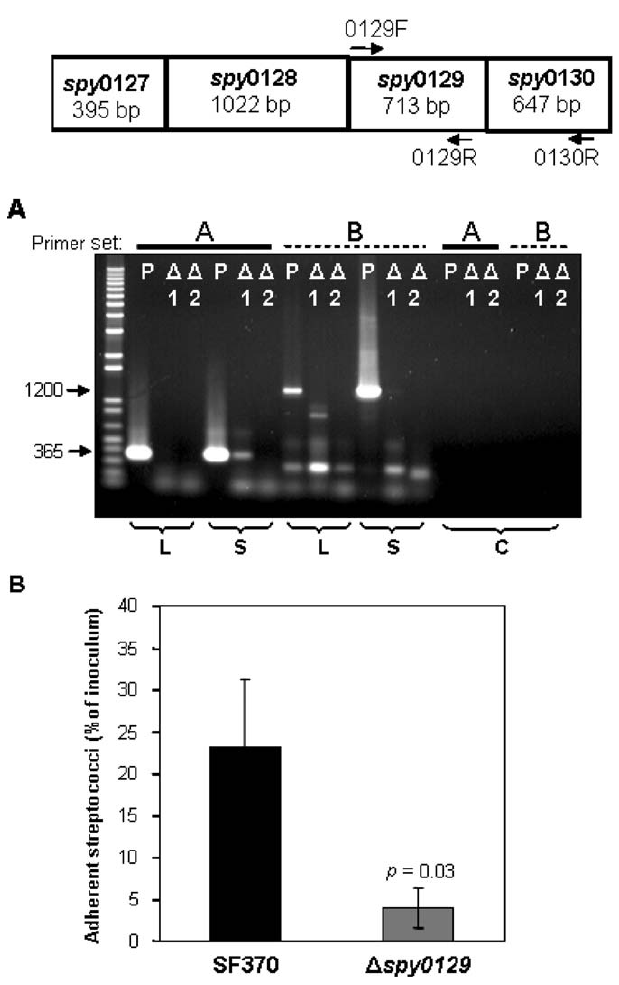
Figure 4. Confirmation of spy0129 Deletion Mutant and Adherence Assay Top panel is a schematic representation of the spy0127–0130 cluster. Position of primers for RT-PCR are indicated by arrows. (A) Results of RT-PCR analysis on mRNA from two putative deletion mutants ( D 1 and D 2) and the parental SF370 strain (P). mRNA was isolated from mid log-phase or stationary phase cells (indicated below panel) and reverse-transcribed with two primer combinations, which are indicated at the top of the lanes as primer set A (0129F–0129R) and primer set B (0129F–0130R). cDNA products were separated on a 1% agarose gel and visualized by ethidium bromide staining. The expected sizes of resulting cDNAs from SF370 using primer set A is 365 bp and using primer set B is 1200 bp. Control reactions (C) containing mid-log phase mRNA and Taq DNA polymerase instead of reverse transcriptase are indicated. Lane 1 contains 1 kb Plus DNA ladder (1 l g; Invitrogen). (B) Results of the pharyngeal cell adherence assay (detailed in Methods), comparing parental strain SF370 to the spy0129–0130 isogenic mutant, SF370 D spy0129 .2 (abbreviated as D spy0129 ). Adherent streptococci are reported as the percentage of total number of streptococci added as inoculum to pharyngeal cell monolayers. Statistical significance (reported as p -value) was determined by Student’s t- test.